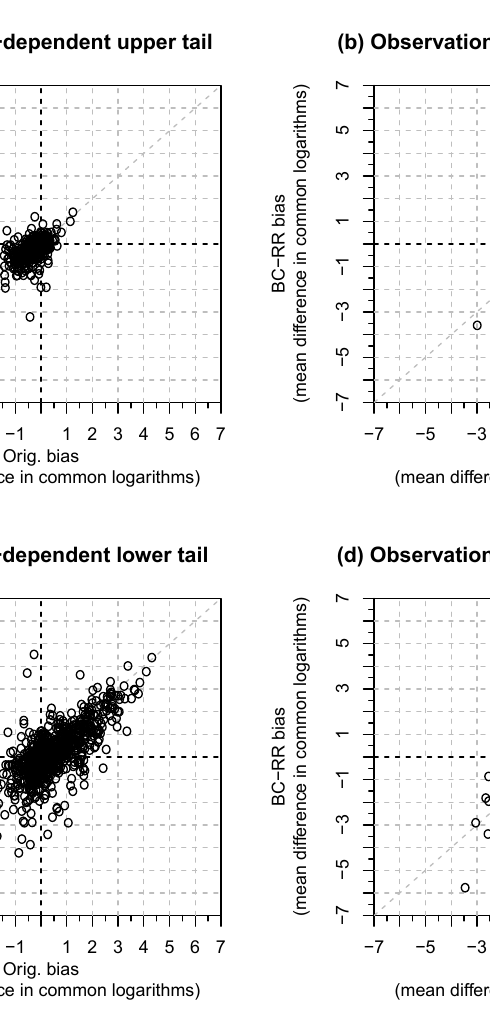
Figure 10. Scatter plots showing the correspondence of logarithmic bias, measured as the mean difference between the common logarithms of simulated and observed streamflow (simulated minus observed) at 1168 streamgages across the conterminous USA for observation- dependent and observation-independent upper and lower tails. Observation-dependent tails retain the ranks of observed streamflow, while matching simulations by day. Observation-independent tails rank observations and simulation independently. The upper tail considers the highest 5% of streamflow, while the lower tail considers the lowest 5% of streamflow. Orig. refers to the original simulation with pooled ordinary kriging, and BC-RR refers to the Orig. hydrograph bias-corrected with regionally regressed flow duration